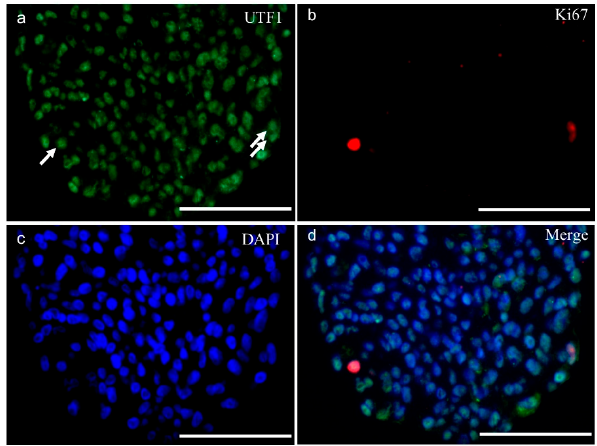
Figure 4. SSC-like cell clusters contain a few proliferating cells. Double immunofluorescence staining of SSC-like cell clusters ( a ) undifferentiated embryonic cell transcription factor 1 (UTF1); ( b ) antigen KI-67 (Ki67); ( c ): nuclear staining with 4 ′ ,6-diamidino-2-phenylindole (DAPI); ( d ) merged from three channels. Arrows showing the proliferating cells in the surface layer of clusters. Scale bars: 50 µm.